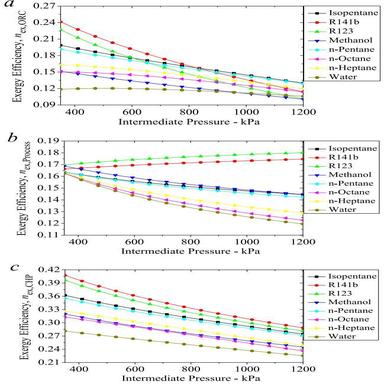
Effect of intermediate pressure on exergy efficiencies in ORC (a) Process (b) CHP (c).